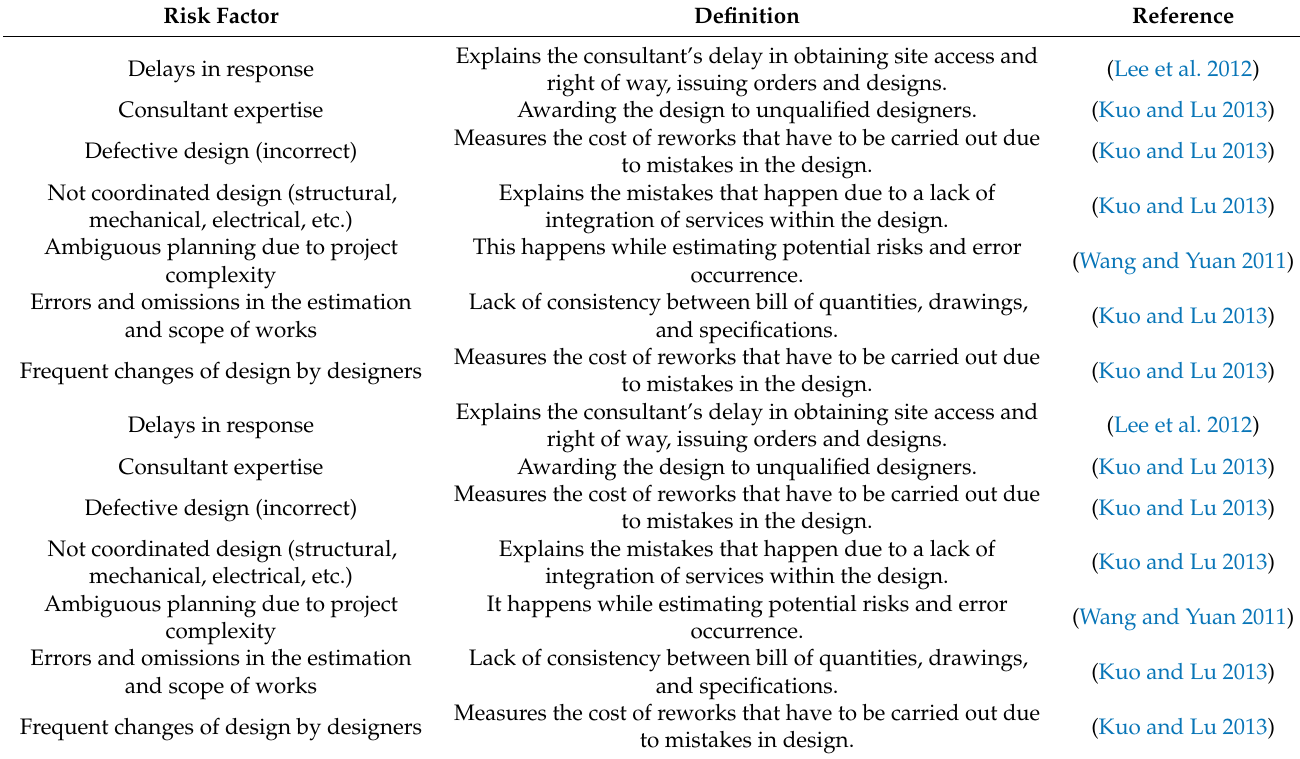
Table 2. Risk factors related to cash flow forecasting attributed to consultants.